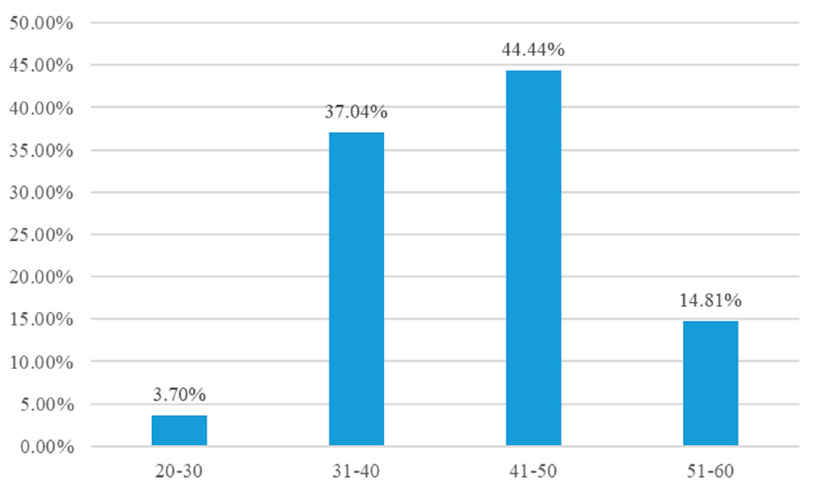
Figure 2. Mean age of CICT of HCMs in Spain. Table 4. Centers involved in